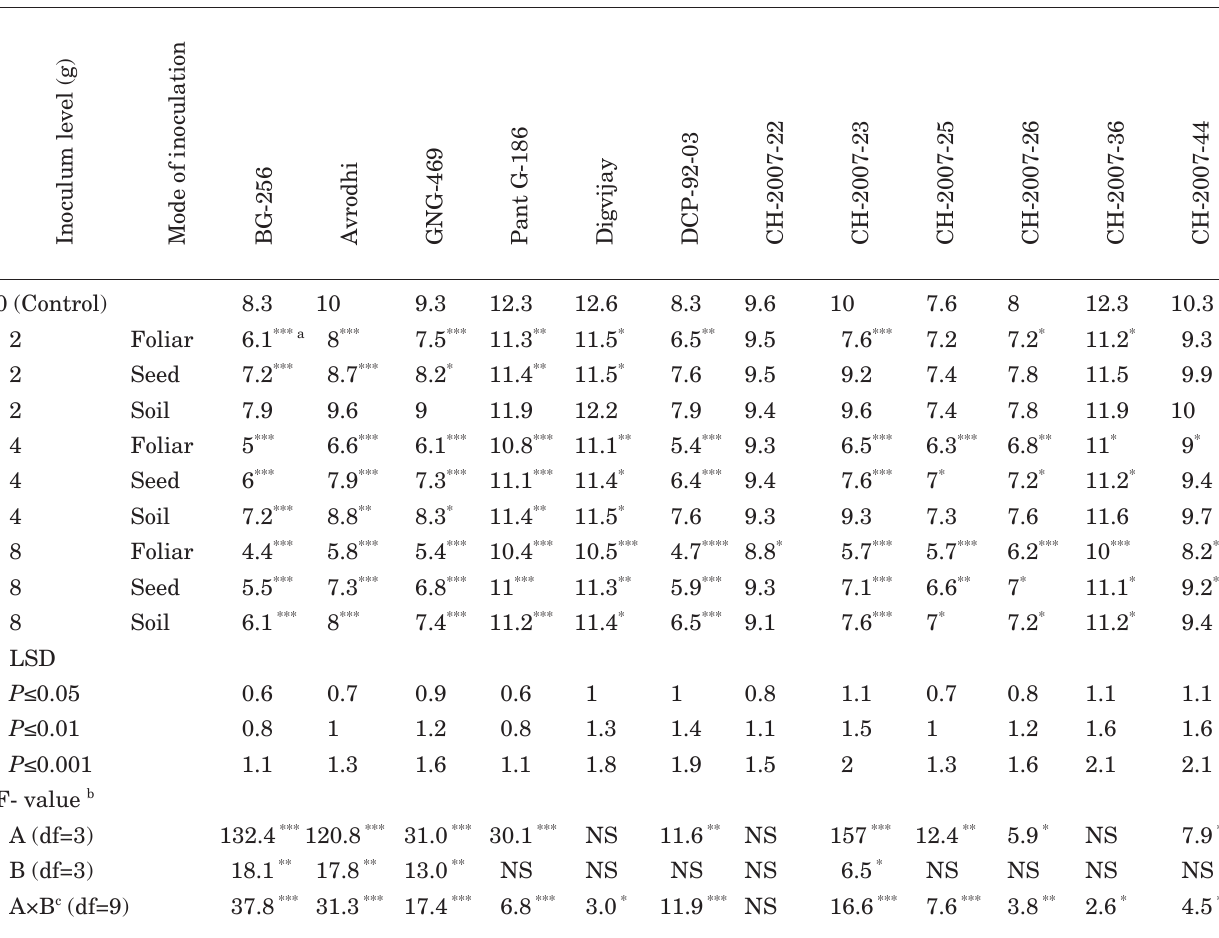
Table 3. Chickpea cultivars receiving foliar, seed and soil inoculation with 2, 4 and 8 g inoculum level of Botrytis cine- rea : effect on dry weight (g plant -1 ) of